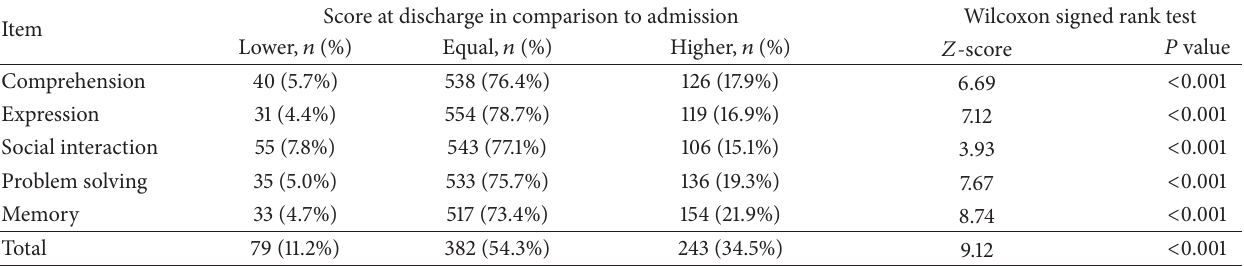
Table 2: Change in Functional Independence Measure Cognitive items scores between admission and discharge from subacute rehabilitation.